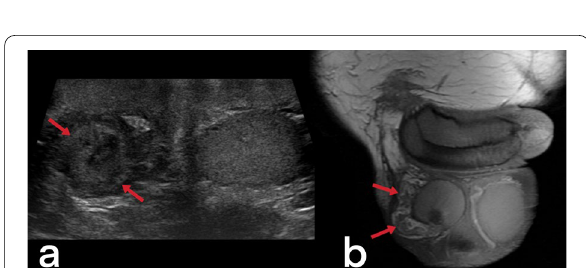
Fig. 40 A 38-year-old male. Scrotal US image ( a ) and post-contrast coronal T1 weighted MR image ( b ) reveal diffuse heterogeneity, deformation, and dilated cystic lump with peripheral enhancement in the right epididymis (arrows)